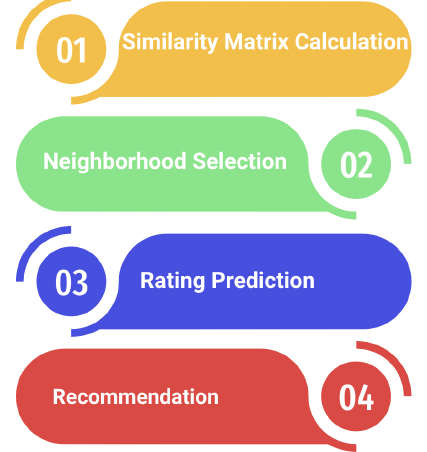
Figure 2. Flowchart of the Collaborative Filtering